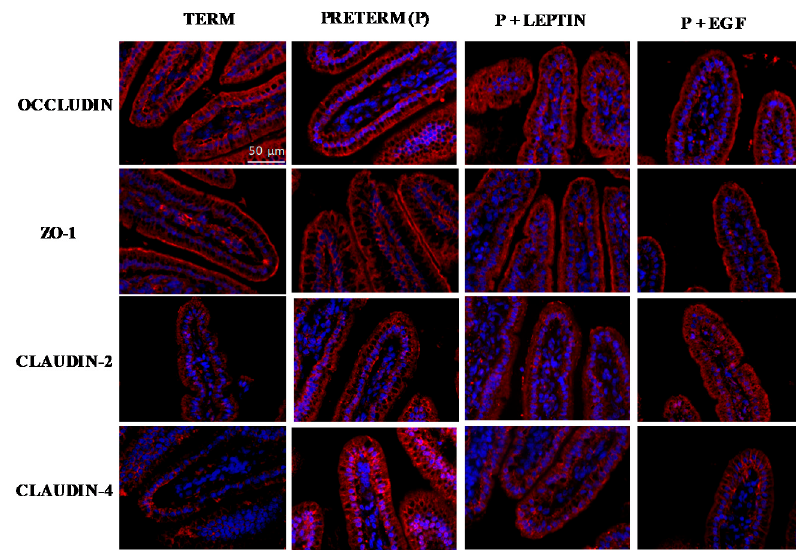
Figure 10. Immunofluorescent staining of small intestine tissue for occludin, ZO-1, claudin-2, and claudin-4. Representative images from Term (T), Preterm (P), P+Leptin, and P+epidermal growth factor (P+EGF) intestines at day 10. Similar results were obtained in five animals in each group. Nuclei were stained with DAPI (blue). Localization of occludin, ZO-1, claudin-2, and claudin-4 (red) were observed by fluorescence microscopy at 400× magnification. Scale bar: 50 μ m.